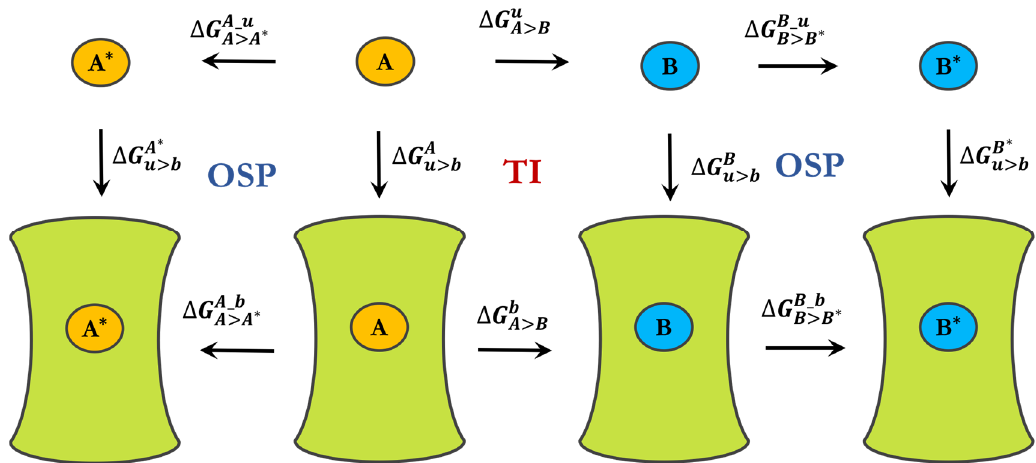
Figure 4. Thermodynamic cycle connecting various states. A and B represent di ff erent ligands, A* and B* ligands with modified partial charges. ∆ G u > b is the free energy of binding (u for unbound, b for bound), while ∆ G A > B is the free energy di ff erence between states A and B. Free energy di ff erences along horizontal arrows in the central square are computed using thermodynamic integration (TI), horizontal arrows in the flanking squares by the one step perturbation